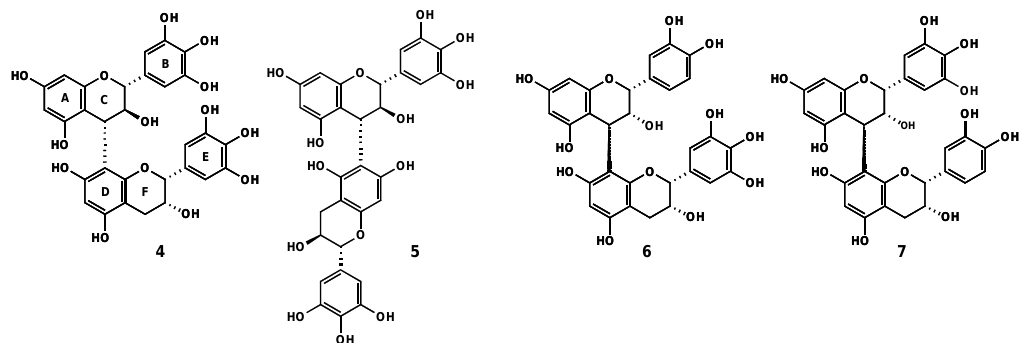
Figure 7. Structures of proanthocyanidins 4 - 7